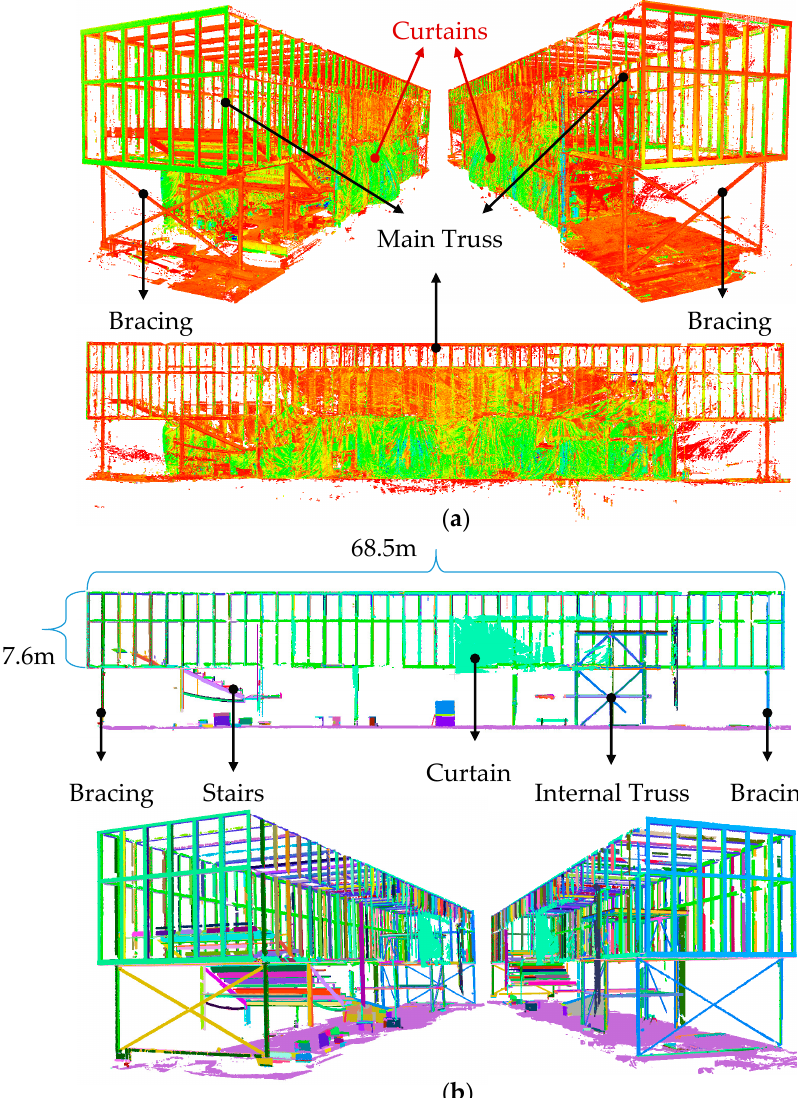
Figure 13. ( a ) point cloud of the TITL building during construction; and ( b ) result of the robust planar segmentation of the whole site.